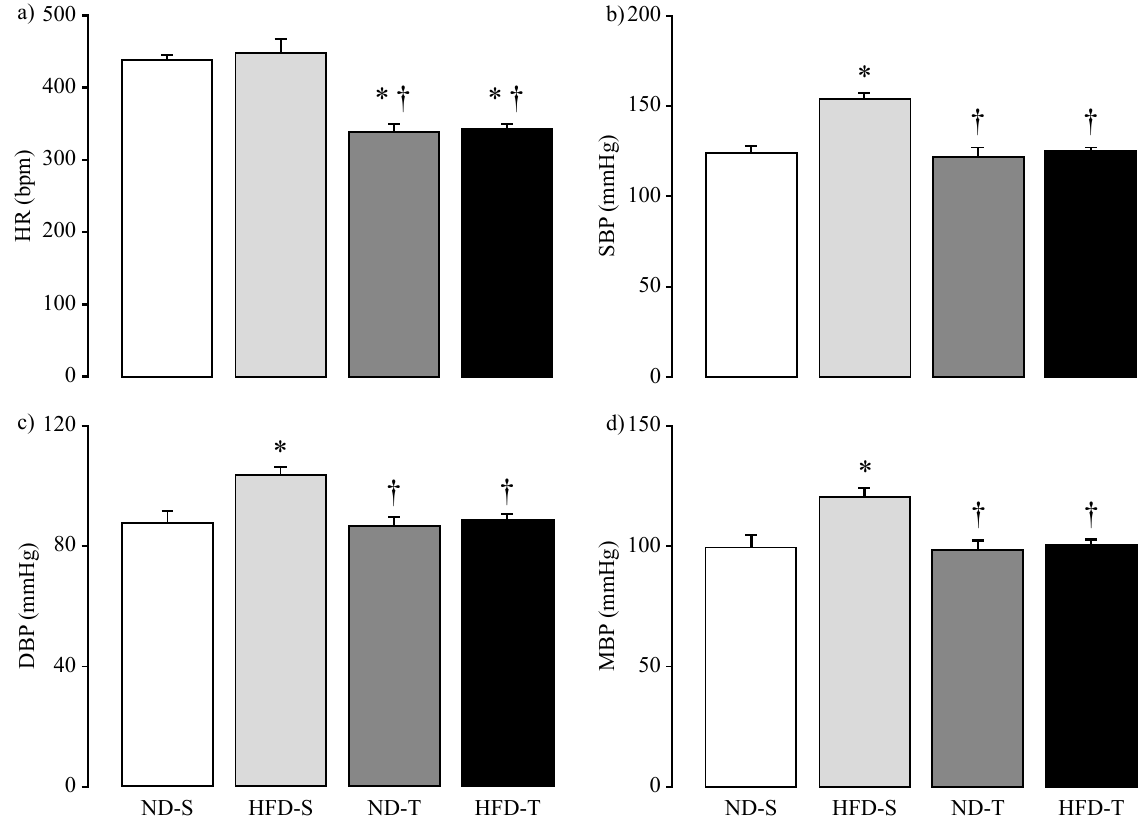
Figure 1. Values of (a) resting heart rate (HR, bpm), (b) systolic blood pressure (SBP, mmHg), (c) diastolic blood pressure (DBP, mmHg) and (d) mean blood pressure (MBP, mmHg) in non-anesthetized Wistar rats submitted to normal diet plus sedentary activity (ND-S, n=8), high-fat diet plus sedentary activity (HFD-S, n=8), normal diet plus exercise training activity (ND-T, n=8) and high-fat diet plus exercise training activity (HFD-T, n=8) treatment during 9 weeks. Bars represent mean ± SEM. *p<0.05 vs. ND-S, †p<0.05 vs. HFD-S, ‡p< 0.05 vs. ND-T. (Statistical differences were determined by 2-way ANOVA followed by Tukey post-test).